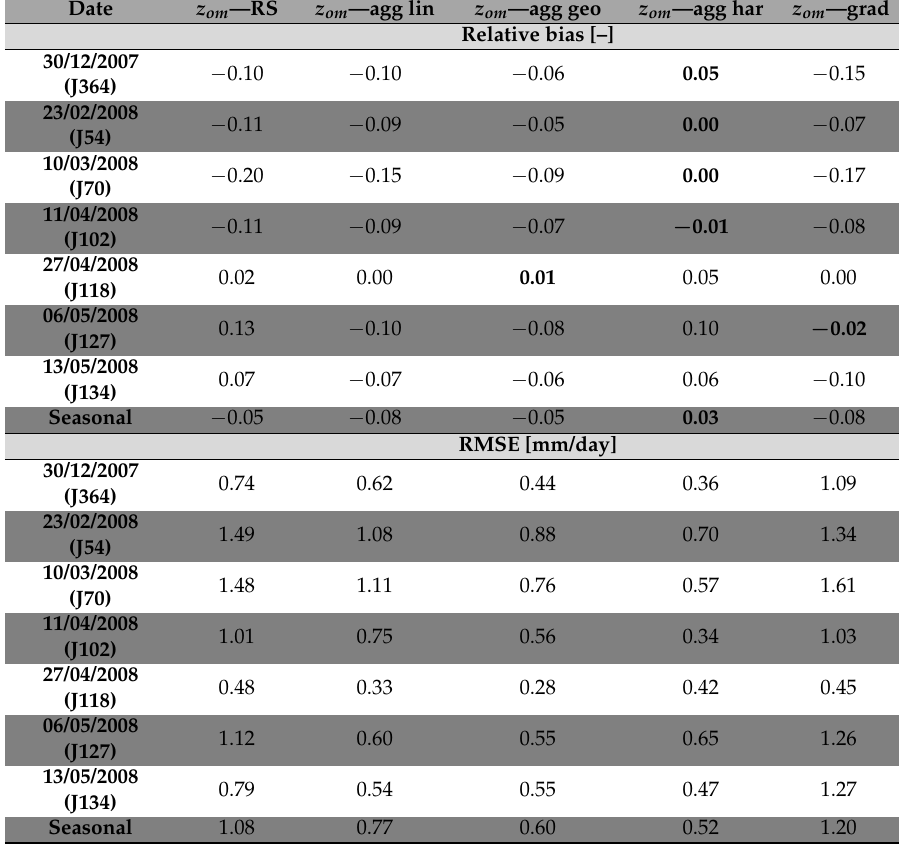
Table 2. Relative biases for the ‘agg ASTER’ vs. ‘LR ASTER’ ET fluxes produced with SEBS at low resolution for different methods to estimate the LR surface roughness length parameter. z om —RS refers to the “remotely sensed” roughness length derived from LR NDVI values, “agg” uses aggregated values from HR to LR using the four methods (“lin”: linear, “geo”: geometric, “har”: harmonic, “grad”: deterministic